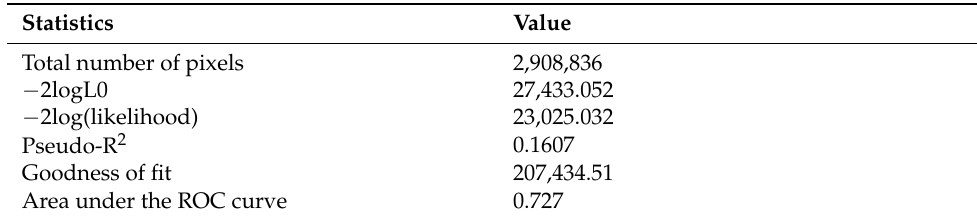
Table 2. Summary of statistics of the logistic regression model.